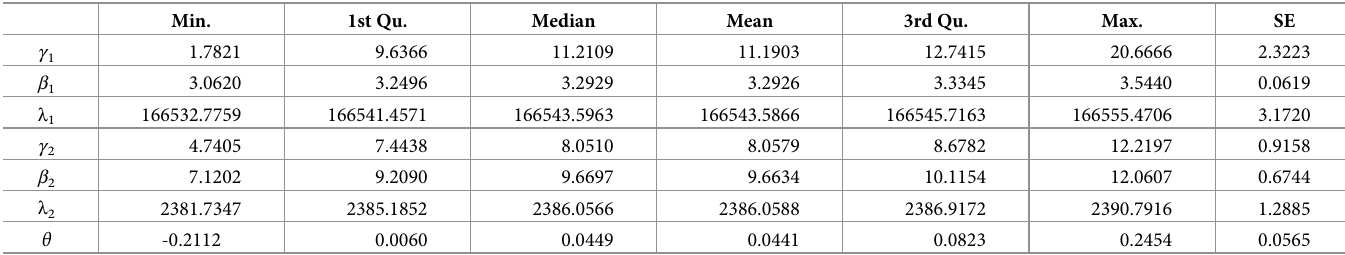
Table 8. MCMC summarized results for parameters of BFGMPLx model.